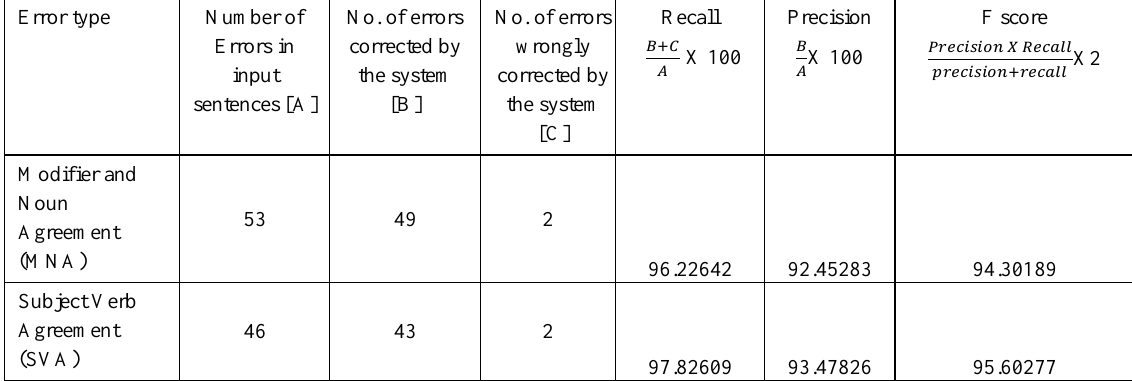
Table 3.2: Experimental evaluation of grammar checking of compound sentences (Real test